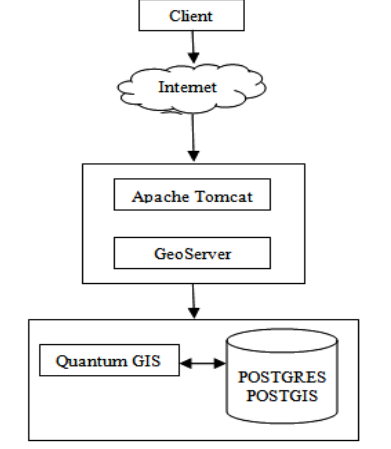
Figure 5: Framework based on Apache